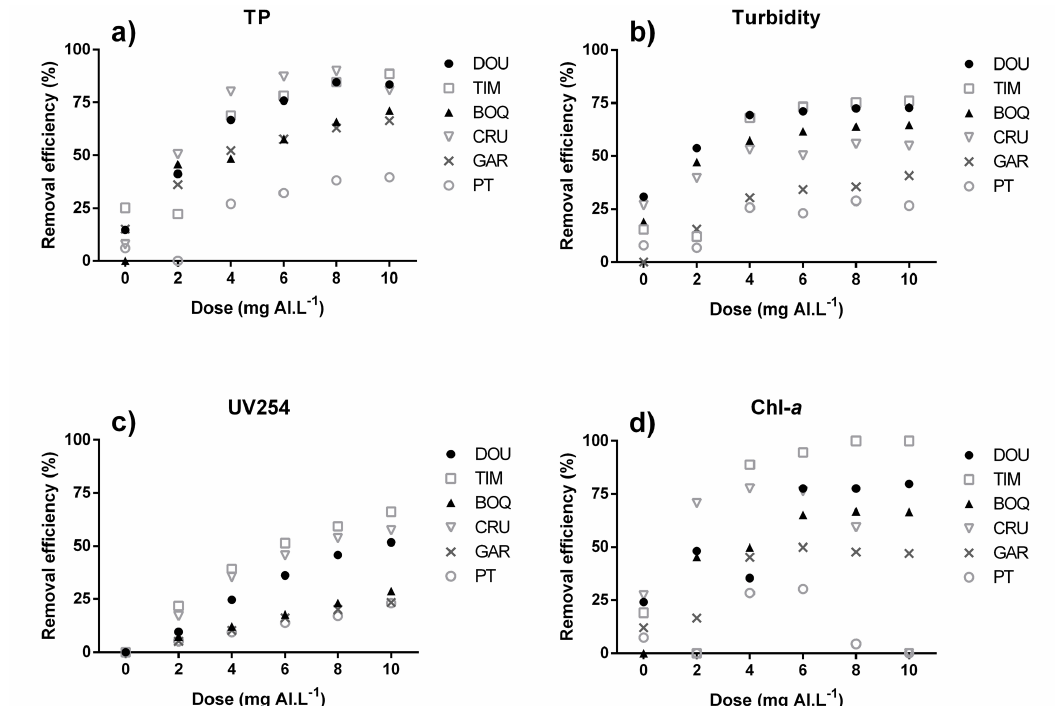
) and chlorophyll-a 254